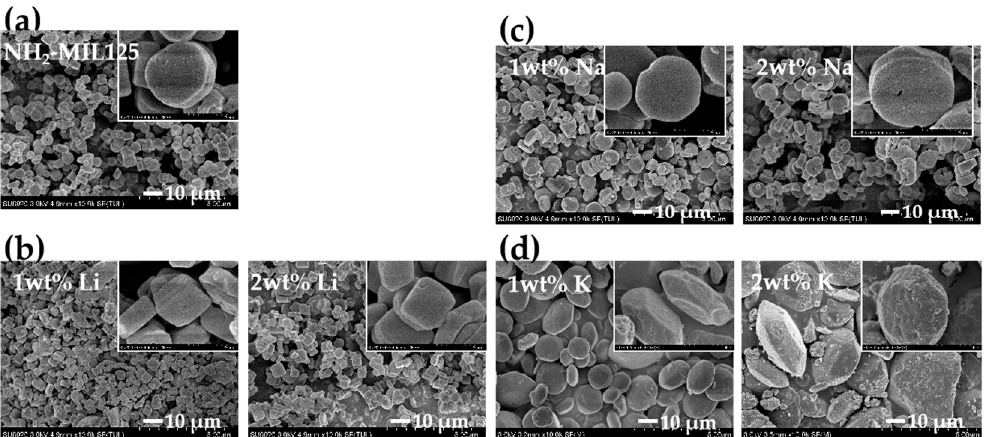
Figure 5. Scanning electron microscopy (SEM) images of doped and pristine NH 2 –MIL125(Ti): ( a ) NH 2 –MIL125(Ti), ( b ) x Li@NH 2 –MIL125(Ti), ( c ) x Na@NH 2 –MIL125(Ti), and ( d ) x K@NH 2 –MIL125(Ti).